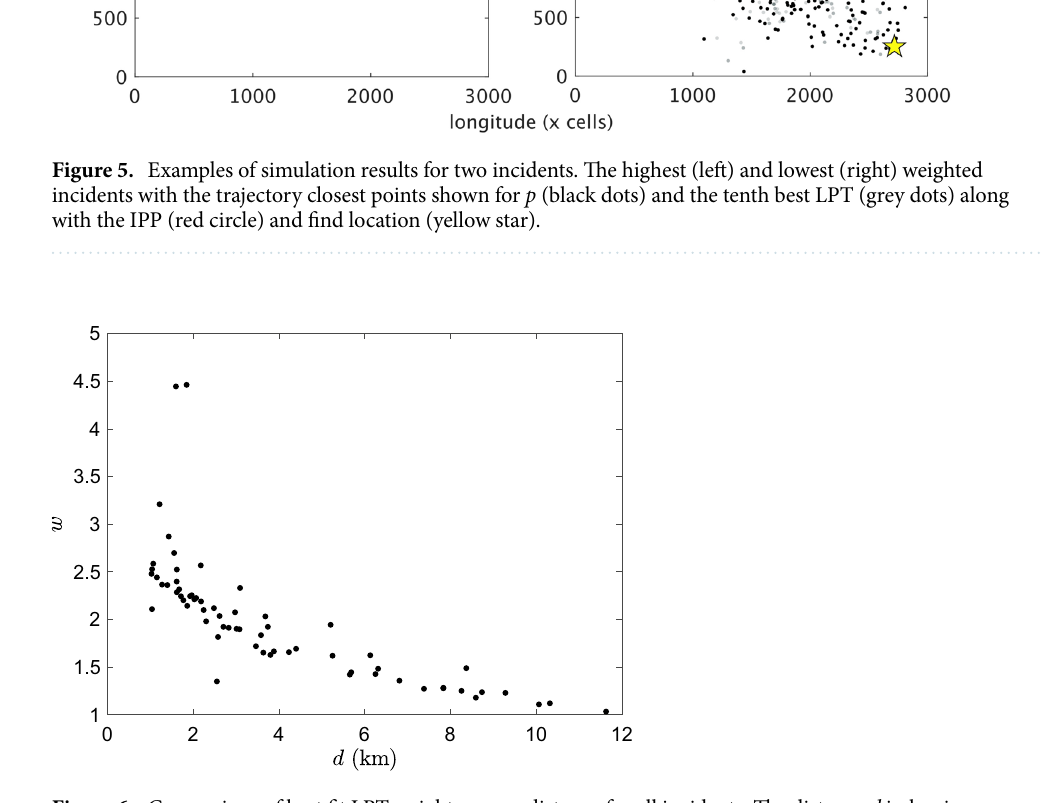
Figure 6. Comparison of best fit LPT weights versus distance for all incidents. The distance d in km is measured from IPP to find location and the corresponding weights w are for all N = 65